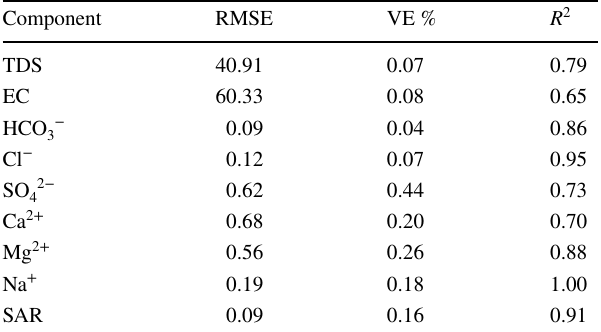
Table 10 Consequences of prediction the 5 years of components